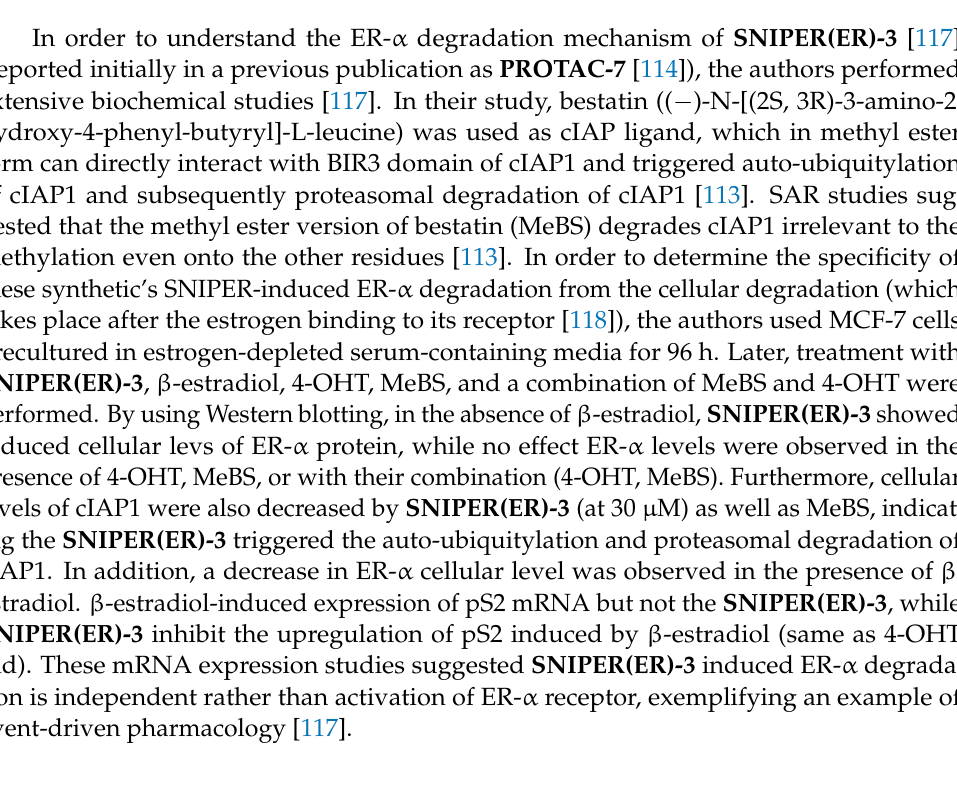
Figure 13. Molecular structures of PROTAC-11 and PROTAC-12 . Note: a typographical error in the linker length of PROTAC-11 was found in Figure 11 from a review by Lin et al. [54] compared to the original structure reported by Itoh et al. (scheme 3) [114].